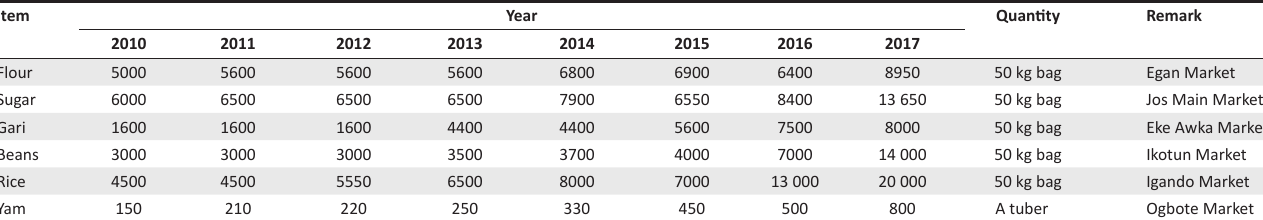
TABLE 1: Market survey from 2010 to 2017.